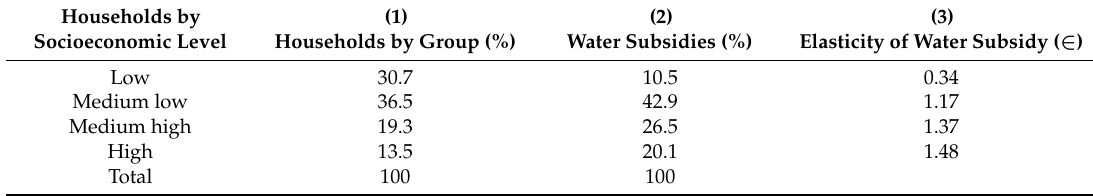
Table 2. Elasticity of water subsidies by socioeconomic group in Mexico City 2011.